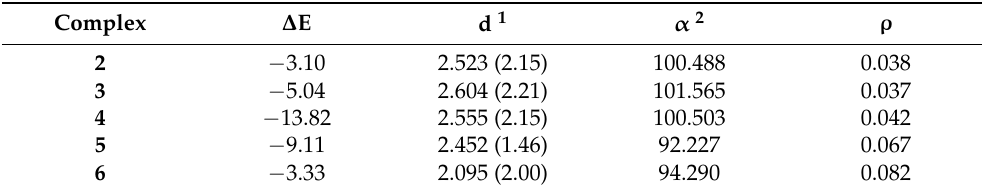
Table 2. Interaction energies ( Δ E, kcal/mol), equilibrium distances (d, Å), N ≡ Os–Cl angle ( α , °) and electron density at the bond critical points ( ρ , a.u.) of complexes 2–6 .